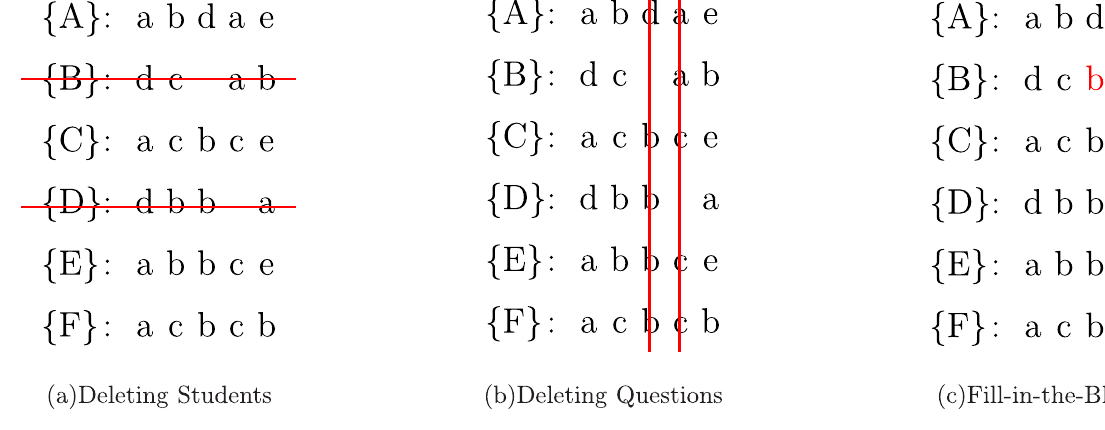
FIG. 1. Strategies for dealing with missing